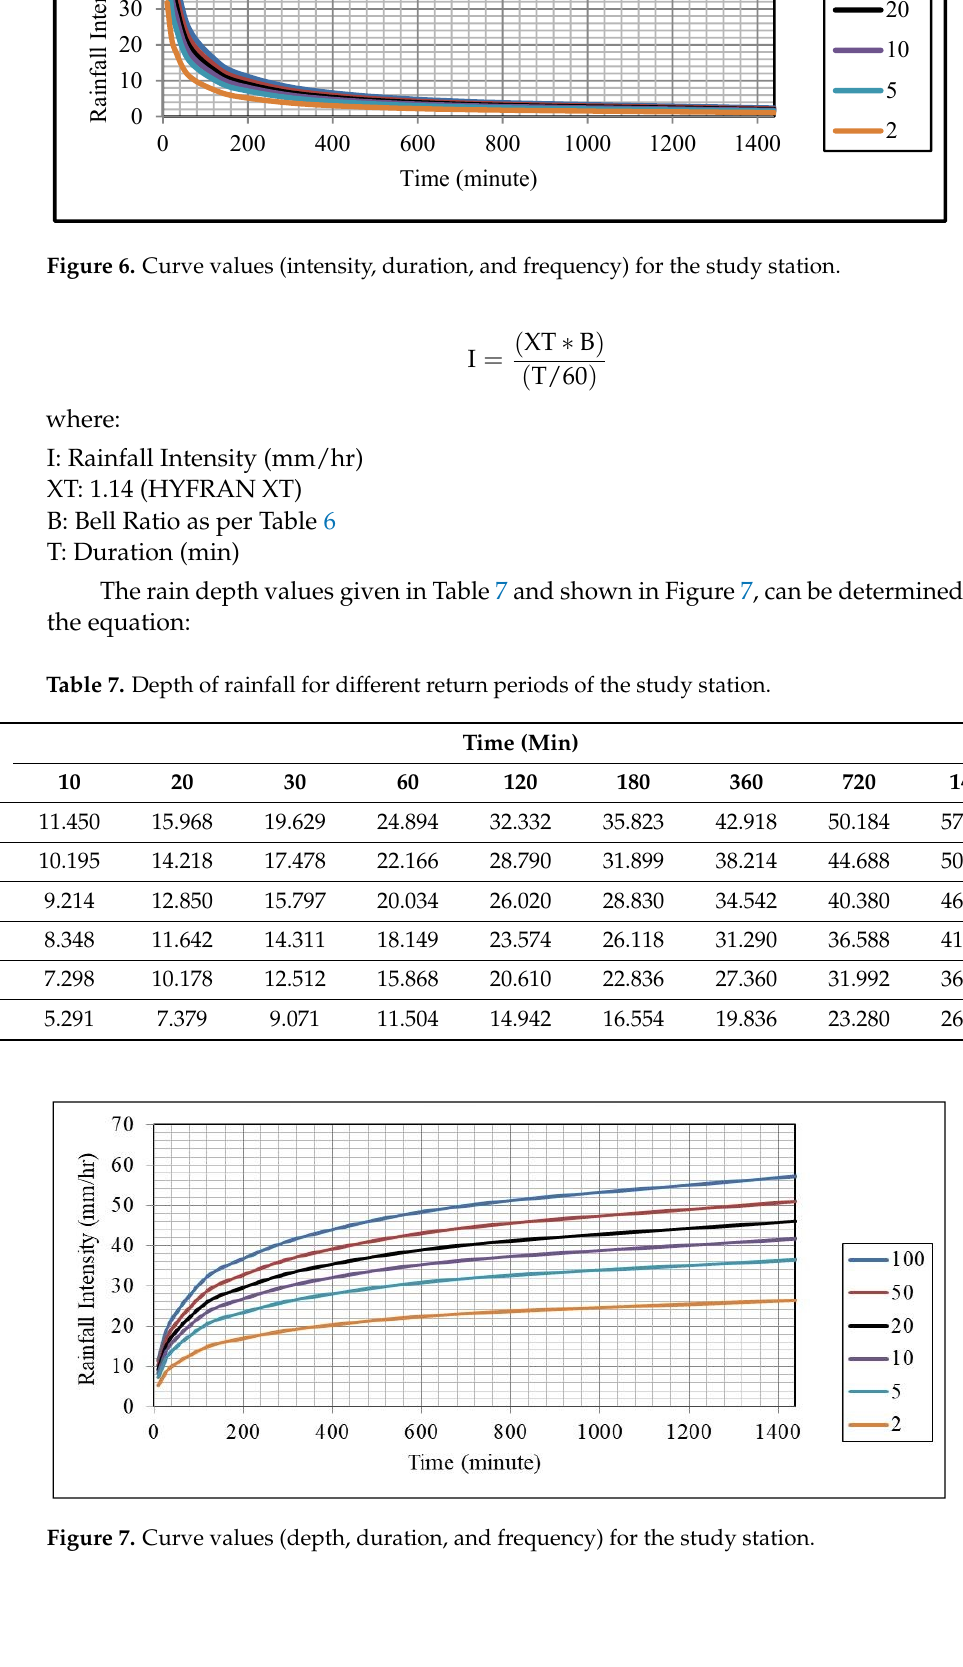
Figure 7. Curve values (depth, duration, and frequency) for the study station.